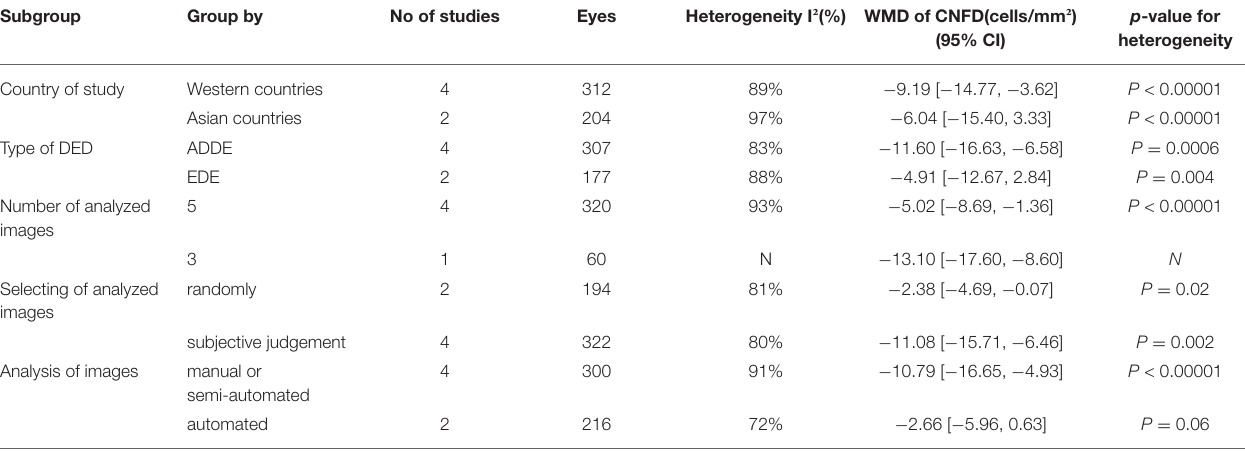
TABLE 2 | CNFD in the central subbasal nerve plexus by various subgroup meta-analyses. Subgroup Group by